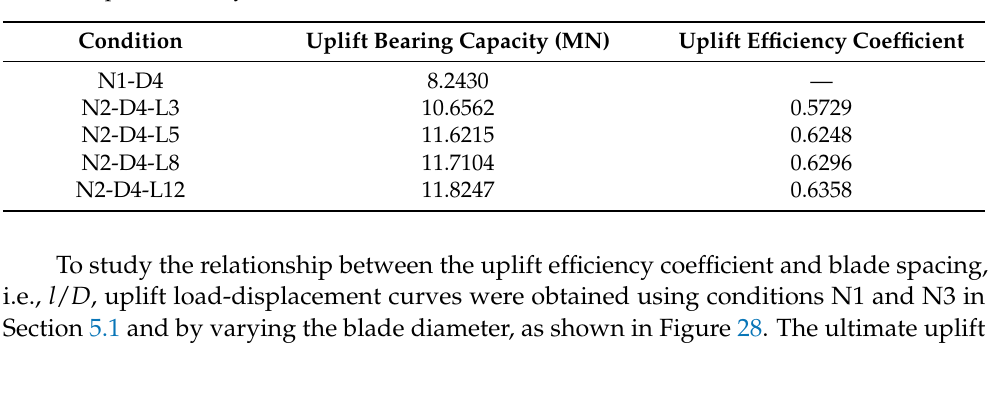
Table 8. Uplift efficiency coefficient ( D / d = 2, n =